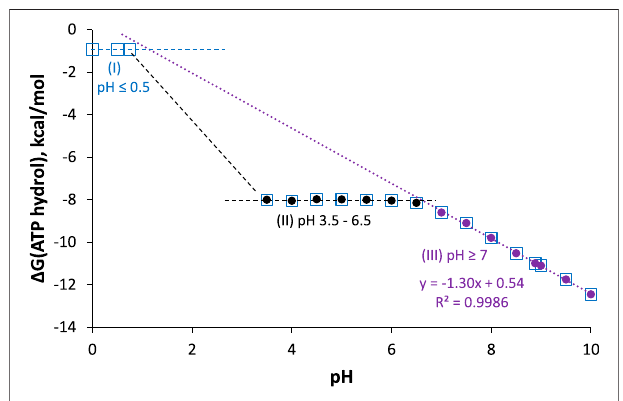
FIGURE8| Δ GforATPhydrolysisasafunctionofpH; I (cid:2) 0.25 M,[Mg 2+ ] (cid:2) 1 mM, T (cid:2) 25 ° C. Data are taken from (Alberty and Goldberg, 1992) and (Méndez and Cerdá, 2016). Measured values are between pH 3.5 – 6.5 (black circles), 7 – 10 (purple circles), and pH 0 (open blue squares). Best- fi t line for pH ≥ 7 points has intercept (cid:2) 0.54 ± 0.17 kcal/mol, slope (cid:2) − 1.297 ± 0.020 kcal/mol/pH unit, R 2 (cid:2)